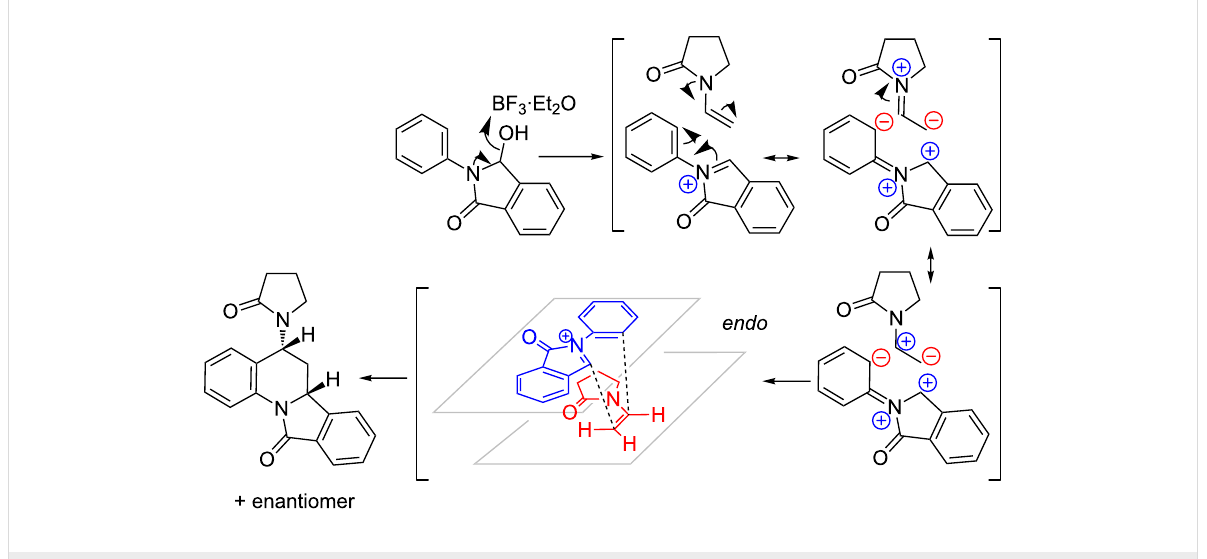
compounds are shown in Figure 2. 1 H and 13 C NMR spectra of all isolated products also indicate formation of a single dia- stereomer as a racemic